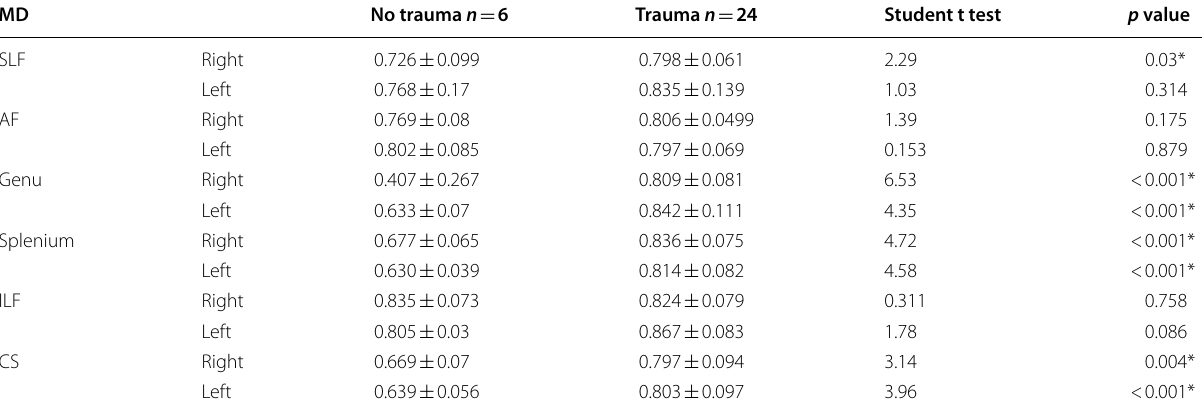
Parameters described as mean *Statistically